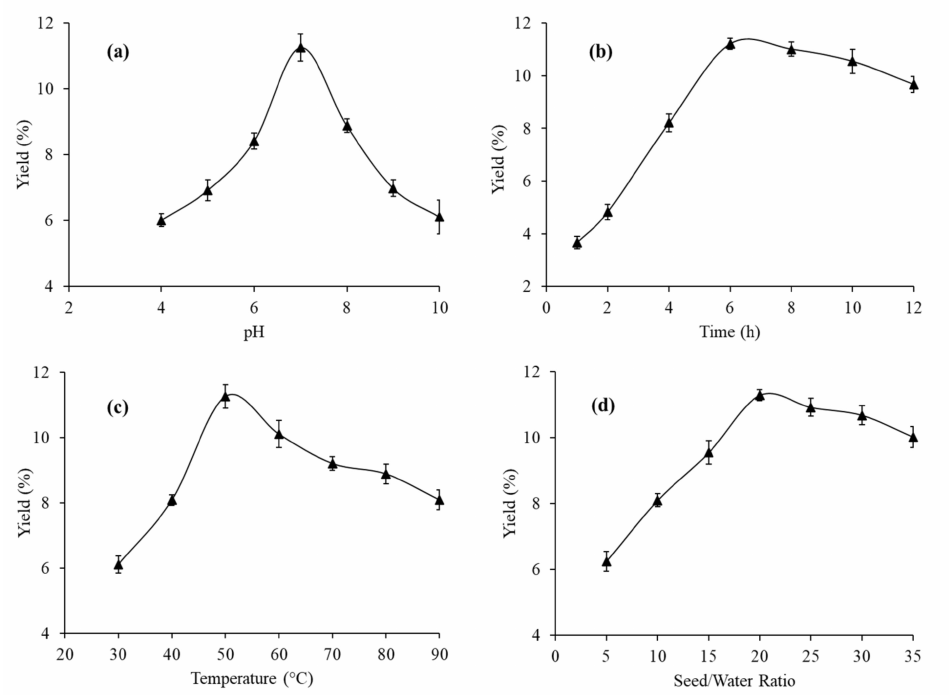
Figure 1. Effect of the pH of extraction medium ( a ), seed/water contact time ( b ), the temperature of the extraction medium ( c ), and seed/water ratio ( d ) on the yield of MPM extracted from MP